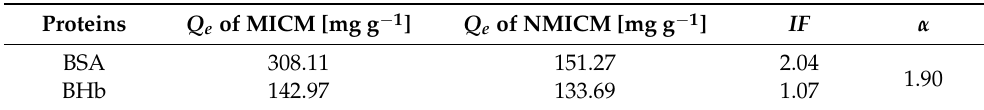
Table 4. The competitive recognition of MICM and NMICM toward BSA and BHb in the protein mixture